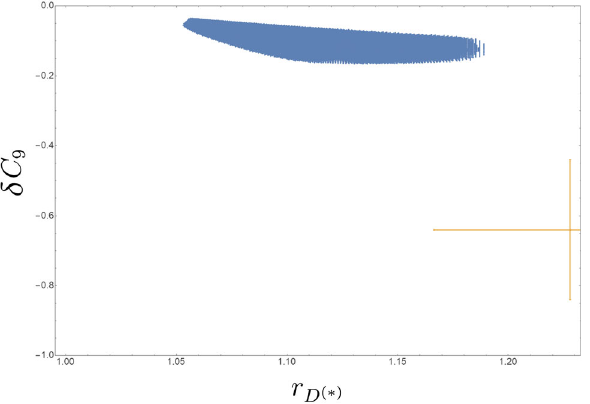
τ/(cid:2) (black) are shown. The parameter space above the contours is τ : (purple), a τ a e